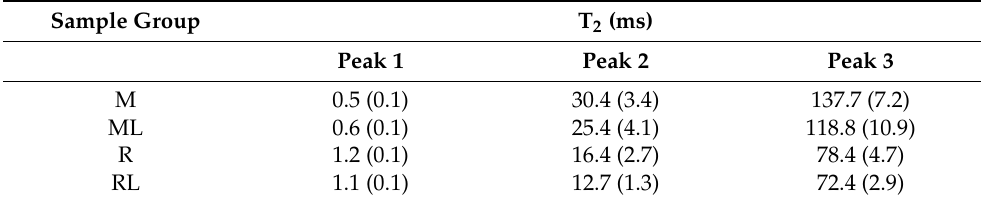
Figure 2. Continuous T ₂ distributions of Scots pine sapwood ( a ) modified and ( b ) untreated averaged over the distributions found for the ten replicates. The dashed line shows sample leached according to EN 84 while solid line shows samples without leaching. Table 2. Peak maximum T 2 relaxation time distributions of Scots pine sapwood modified (M), modified and leached (ML), untreated (R) and untreated and leached reference (RL) at the water-saturated state in LFNMR analysis. Values in parenthesis are standard deviation.